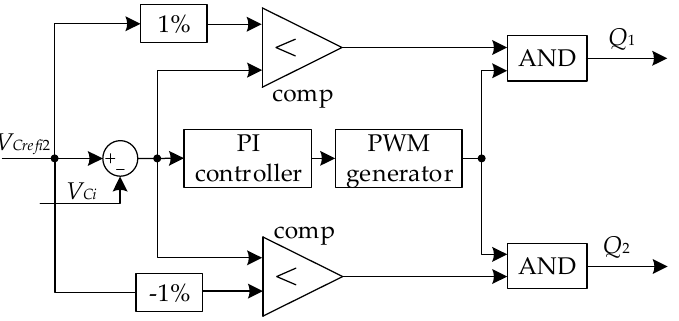
Figure 5. The charging and discharging control of BBC.